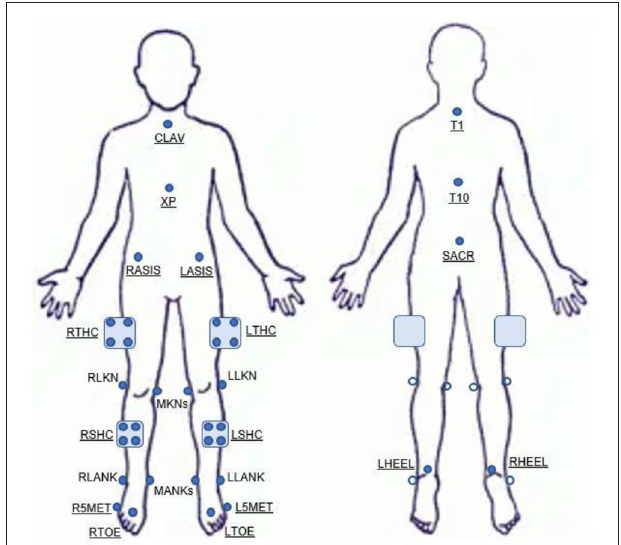
FIGURE 1 | Marker set